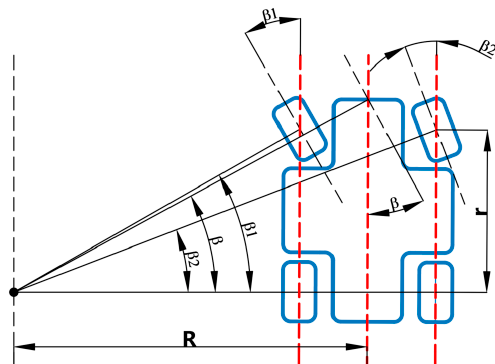
Figure 8. Robot steering diagram. β stands for the turning angle of the robot, β1 for the steering angle of the inner front wheel, and β2 for the steering angle of the outer front wheel.